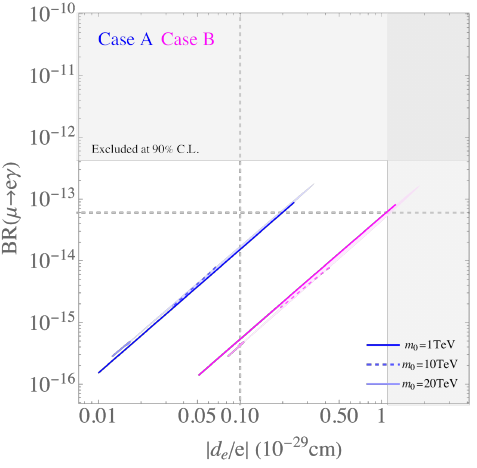
Figure 5 . Plot of | d e /e | and BR( µ → eγ ) Figure 6 . Plot of | d e /e | and BR( µ → eγ ) for for cases A and B with F τ = m 0 / 2 , where cases A and B with F τ = m 0 / 2 , where M m 0 = 1 – 20 TeV for fixed M = 6 and 18 TeV. 1 / 2 6 – 18 TeV for fixed m 0 = 1 , 10 and 20 TeV. The The blue curves denotes the predictions at fixed blue curves denotes the predictions at fixed m 0 gaugino mass M for case A, and the pink one 1 / 2 for case A, and the pink one for case B. The grey for case B. The grey regions are excluded by regions are excluded by the experimental upper the experimental upper bounds, and the vertical bounds, and the vertical and horizontal dashed and horizontal dashed grey lines indicate the grey lines indicate the future sensitivity. future sensitivity.